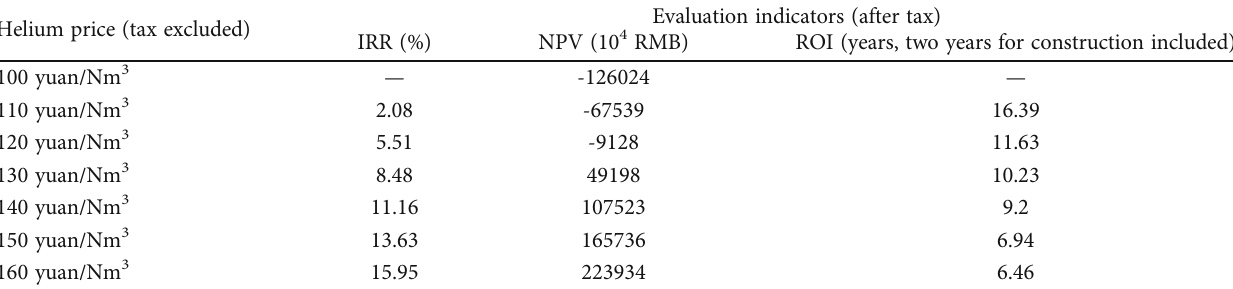
Table 3: Financial indices of helium at di ff erent